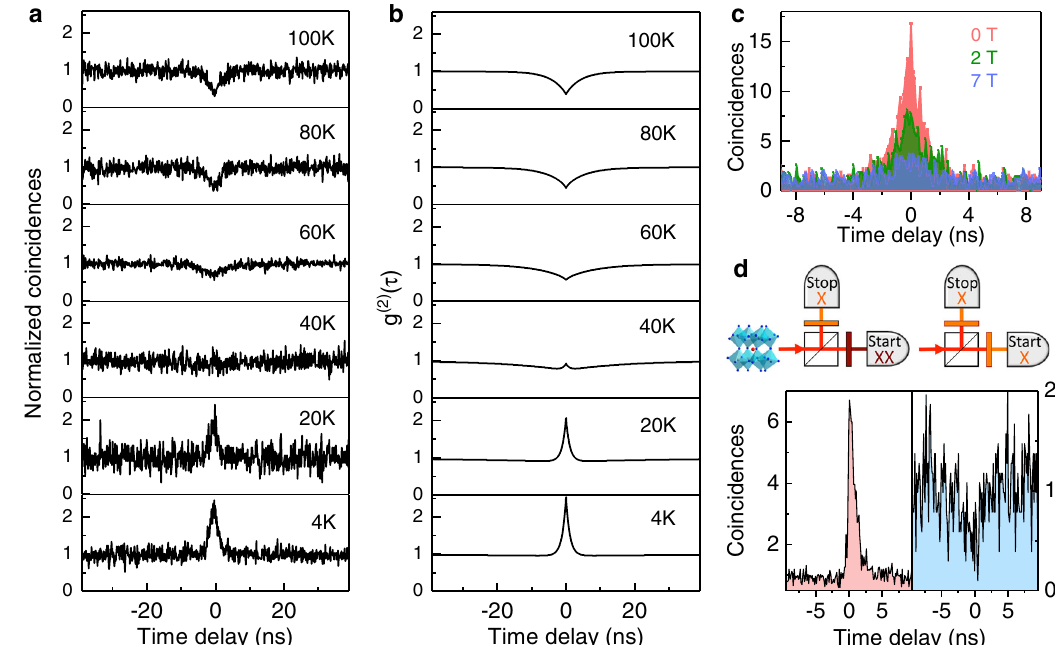
Fig. 5 Tuning the photon statistics of single NCs with temperature and magnetic fi eld. a Normalized photon coincidence histograms of a NC for various temperatures, in zero fi eld and at ~100 W cm − 2 . The photon bunching obtained at low temperatures turns to antibunching as thermal mixing between bright and dark exciton states operates. b Simulations of the PL autocorrelation function with a four-level model described in Supplementary Note 2, taking Γ = 0.9 ns − 1 , Γ ¼ 0 : 01 ns − 1 , γ = 0.1 ns − 1 , α = 3/4, W = 0.01 ns − 1 , η ¼ 0.13, E ¼ 3 meV, E ¼ 5.6 meV. c Photon coincidence histograms at various B 0 D 1 2 XX magnetic fi elds, at 4 K, showing the weakening of the bunching effect with increasing magnetic fi elds. d Photon coincidence histograms measured for the same NC in different conditions of line fi ltering, at 4 K and in zero fi eld. Each histogram is surmounted by the corresponding fi ltering scheme. Left panel: Histogram recorded in a cross-correlation con fi guration, selecting the exciton ZPLs on one channel of the correlation setup and the biexciton ZPLs on the other. The asymmetry of the histogram is a signature of ordered biexciton – exciton – zero exciton photon cascades. Right panel: Histogram recorded with high-pass fi ltering of the exciton ZPLs, showing photon